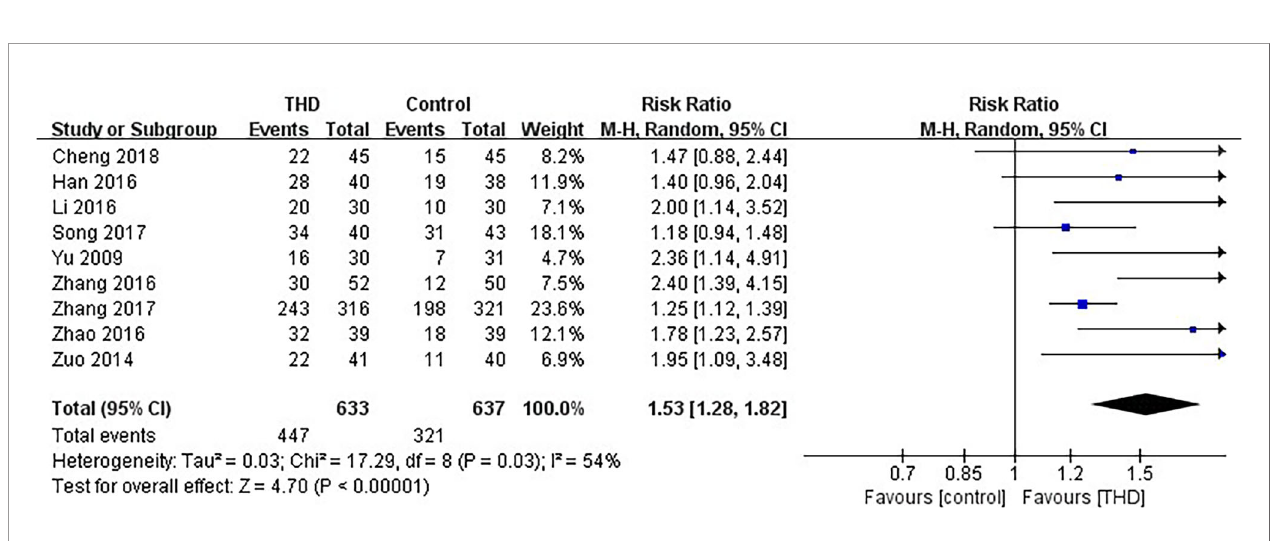
FIGURE 4 | Meta-analysis on CR (delayed phase).